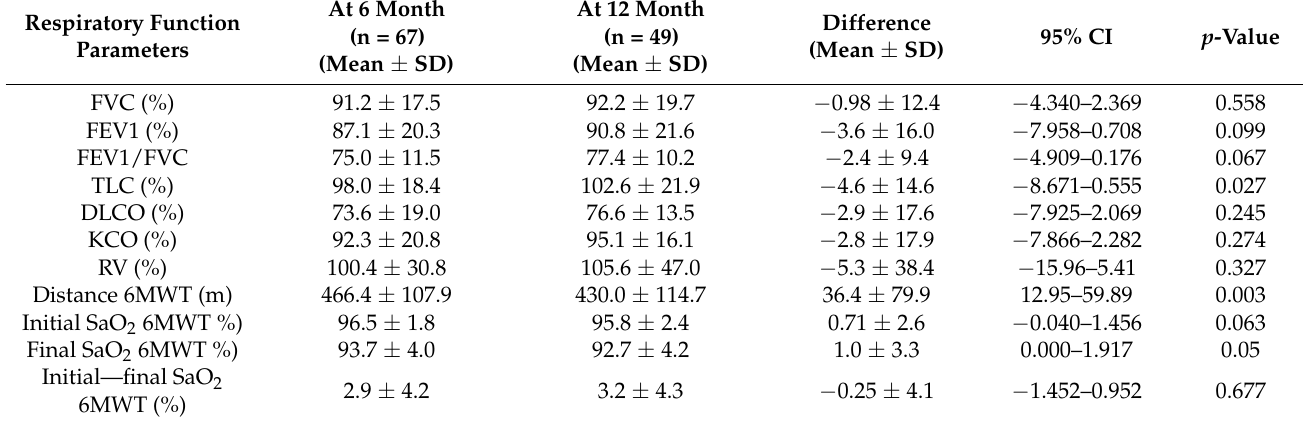
Table 3. Serial values of pulmonary function tests at 6 and 12 months in the subgroup of patients with impaired lung function. Data are expressed as percentage (%) or mean ± standard deviation